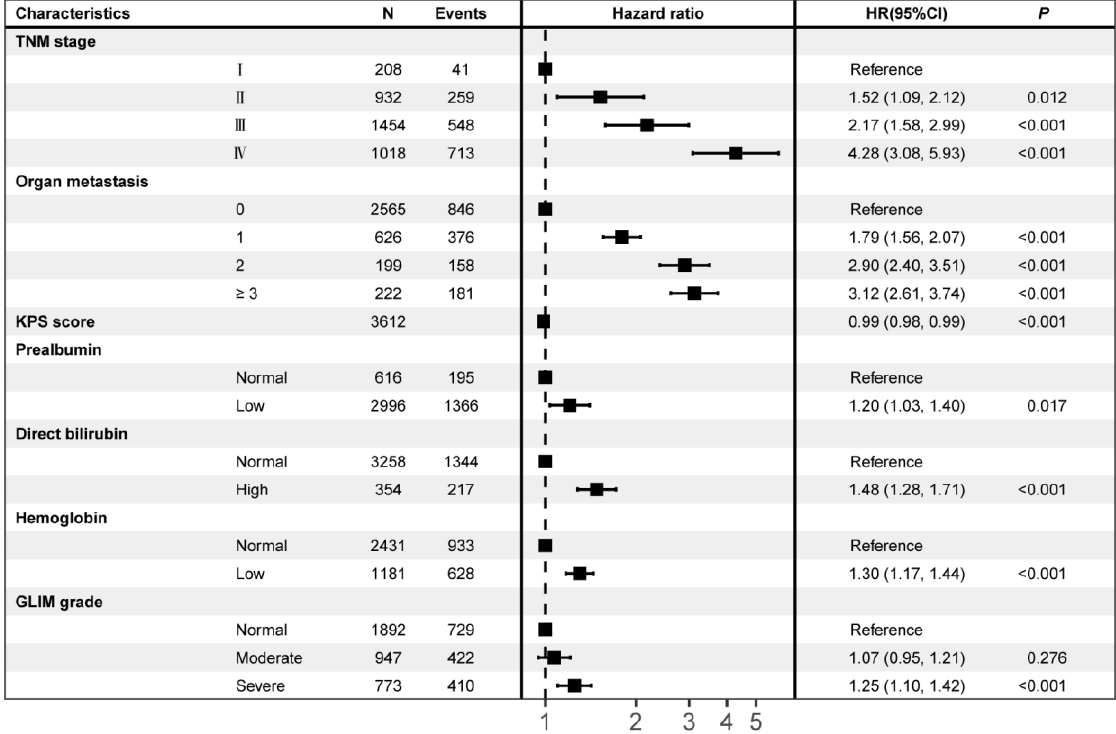
Figure 2. Multivariate Cox Regression Analysis of the Association Between the GLIM Grade and Overall Survival. HR, hazard ratio; CI, confidence interval; KPS, Karnofsky performance score; GLIM, the Global Leadership Initiative on Malnutrition.